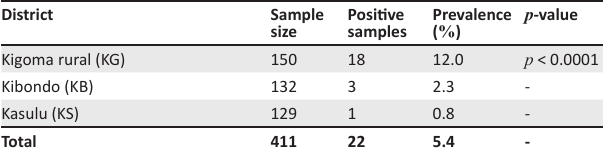
TABLE 1: Prevalence of Rift Valley fever virus infections in Kigoma, Tanzania, May 2011 to June 2011.